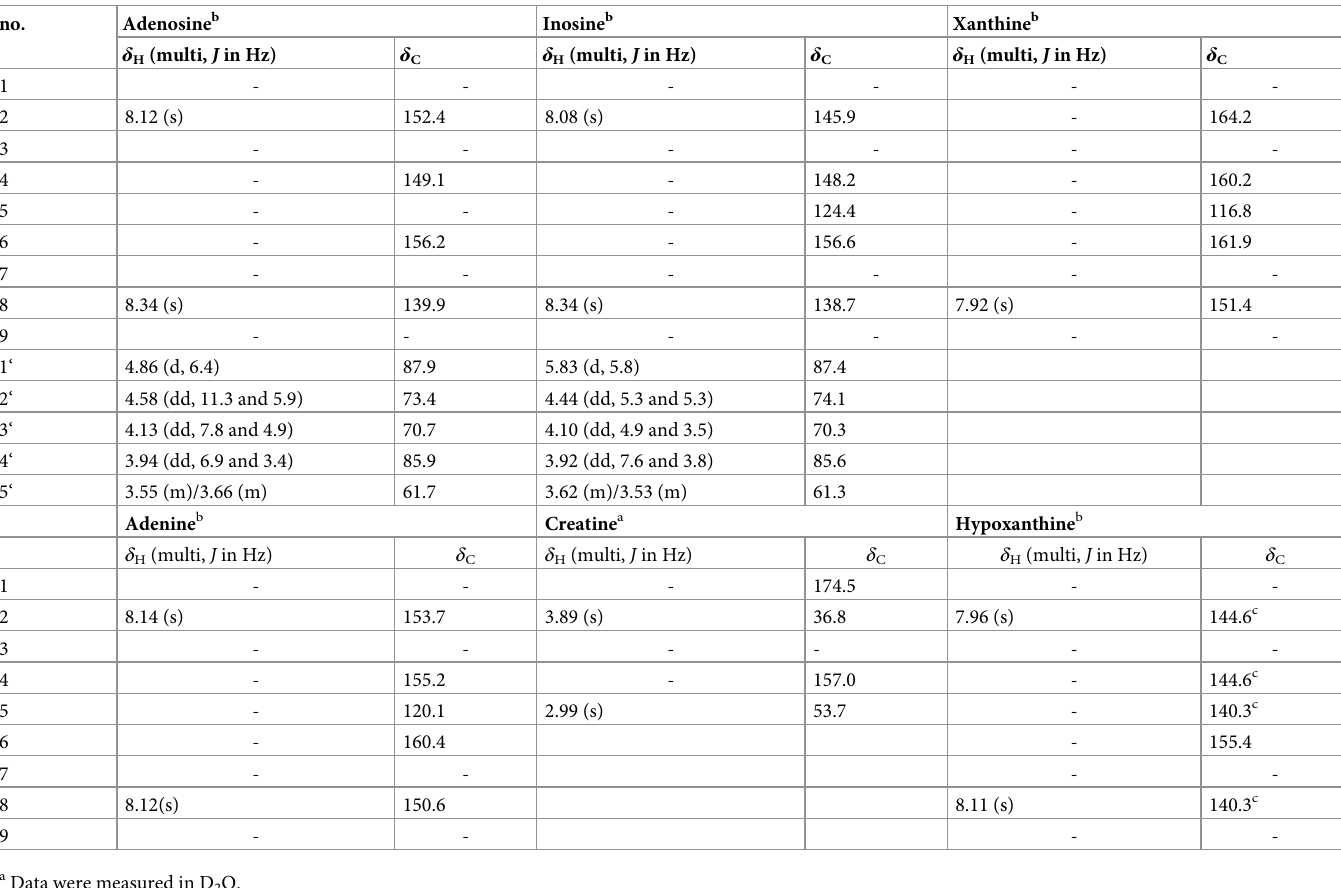
Table 2. 1 H and 13 C NMR spectral data of nitrogenous compounds a,b